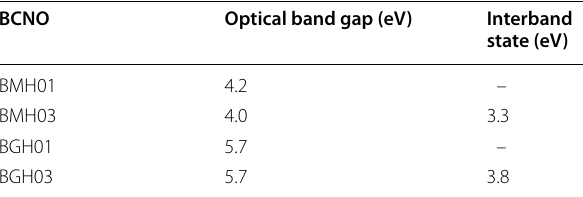
Table 2 Optical bandgap energy and interband states estimated based on Tauc’s